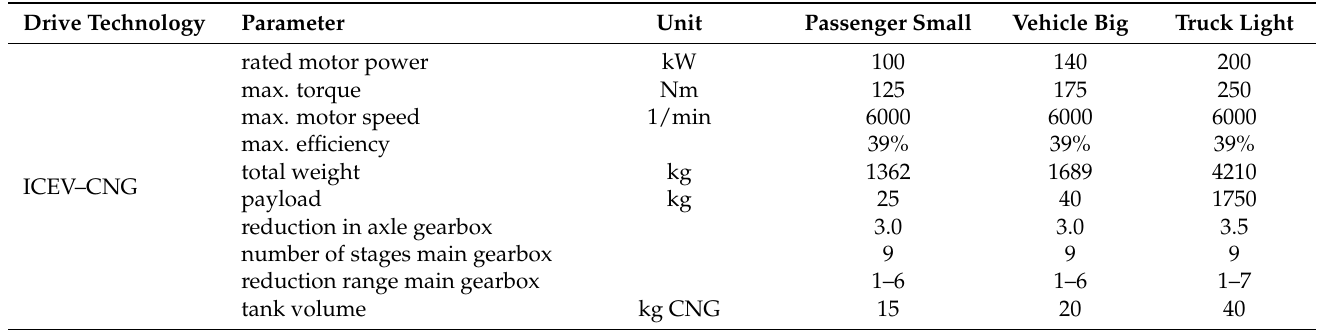
Table 4. ICEV–CNG technical data used in the simulation (2020 state of the art).